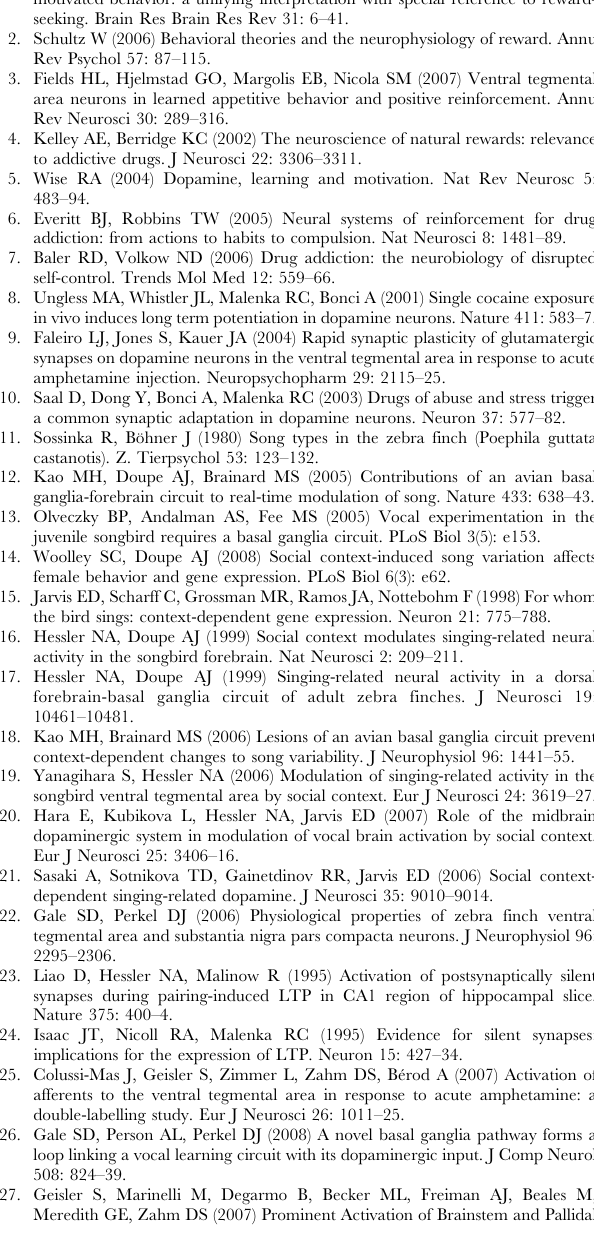
Figure S1 Averages of 30 successive EPSCs for a representative experiment, recorded at a holding potential of + 40 mV, in the presence of 10 uM BMI, BMI + 50 uM APV, and BMI + APV + 10 uM